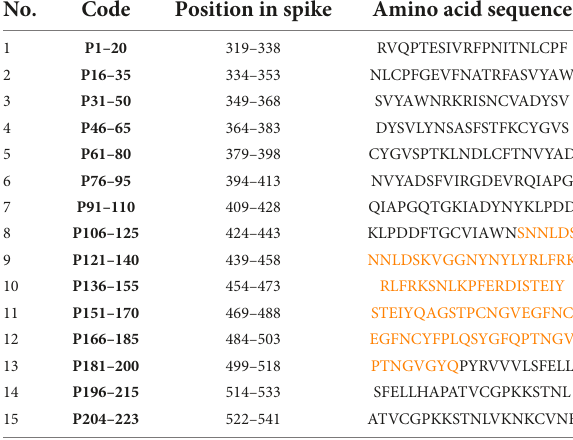
TABLE 1 Amino acid sequences of RBD peptide sets used in